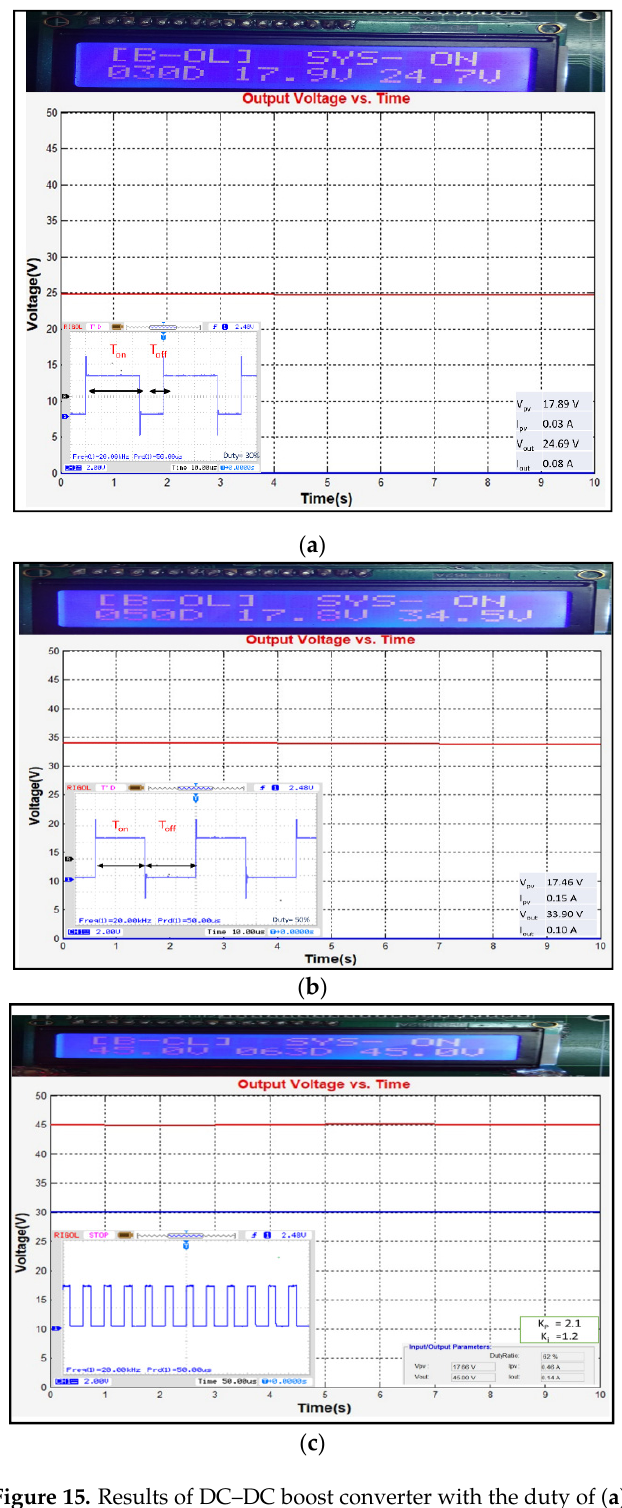
Figure 15. Results of DC–DC boost converter with the duty of ( a ) 30%; ( b ) 50%; and ( c ) 68% for open loop, respectively.